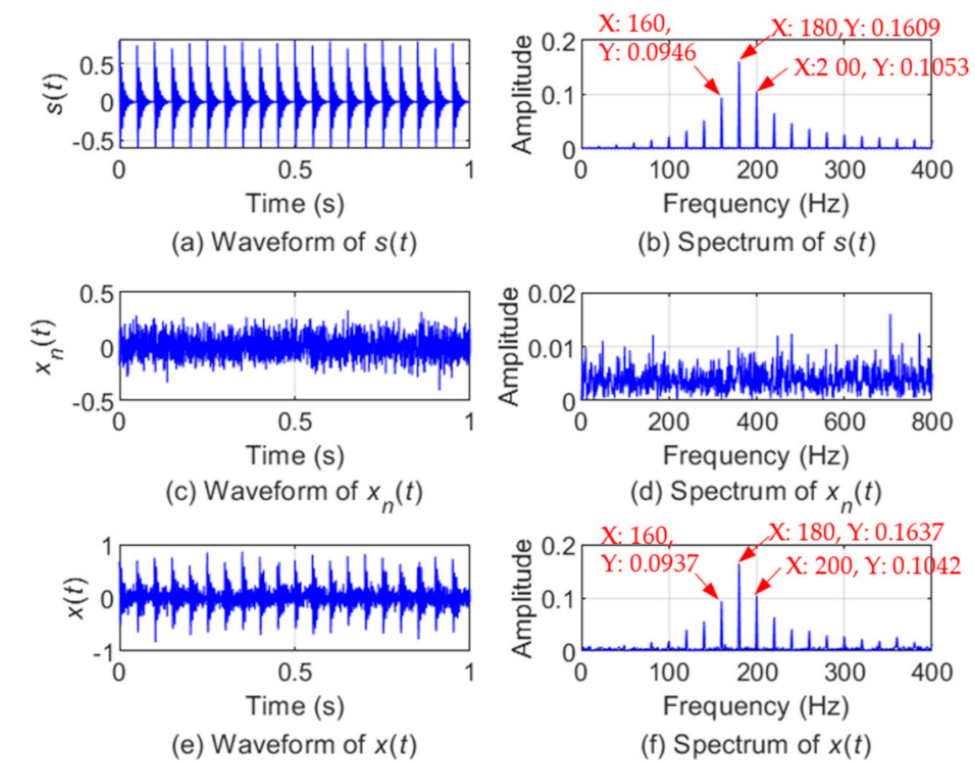
Figure 3. Waveforms of the experimental signals and their